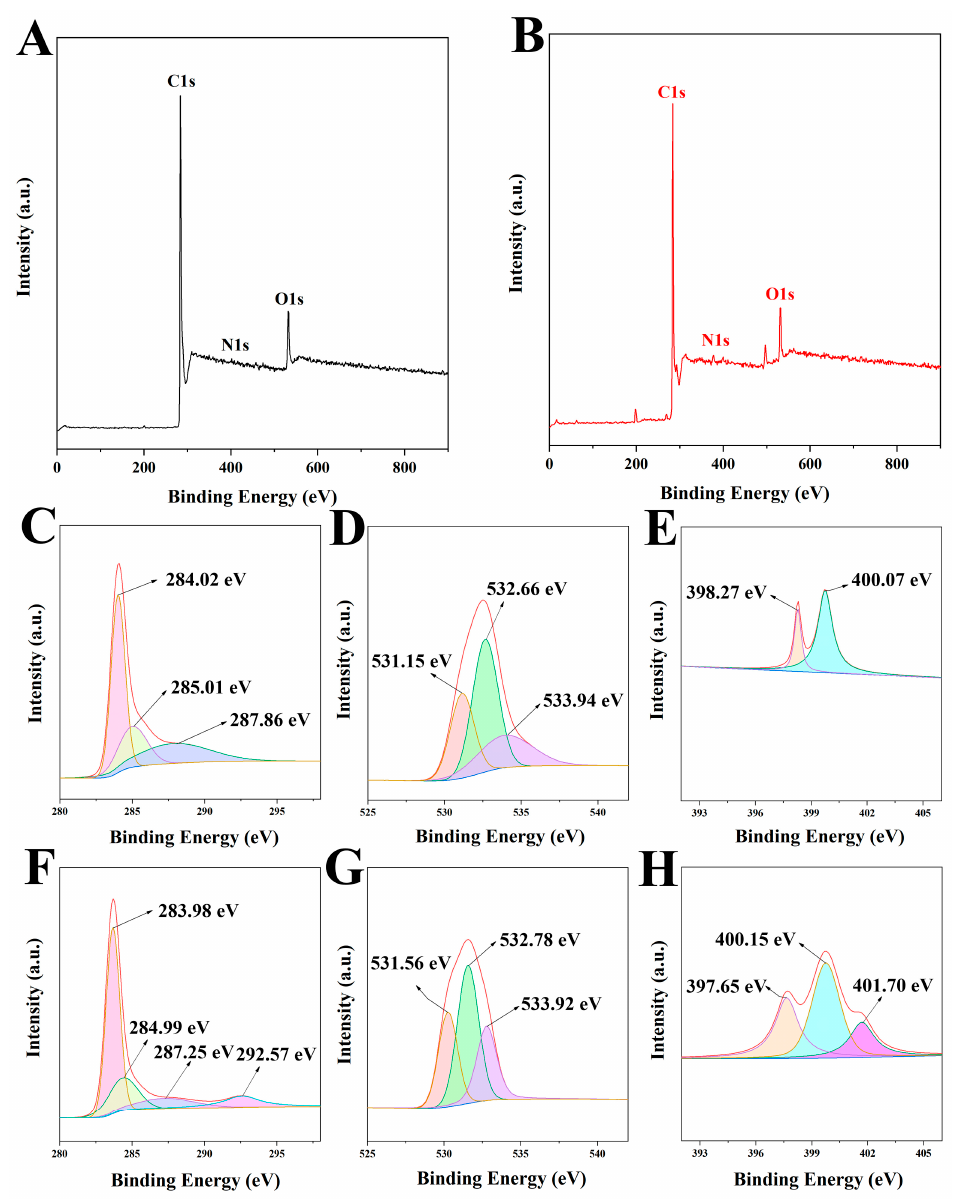
Figure 3. XPS spectra of ( A ) ITGB and ( B ) MITGB. The ( C ) C1s, ( D ) O1s, and ( E ) N1s of ITGB. The ( F ) C1s, ( G ) O1s, and ( H ) N1s of MITGB. The specific surface area and porosity of the sample were tested by N 2 adsorption- desorption isotherms as shown in Figure 4 and Table 1. The specific surface area and the total pore volume of CITG were 129.9 m 2 /g and 0.0729 cm 3 /g, meanwhile, the specific sur- face area and the total pore volume of MITG were 213.1 m 2 /g and 0.1048 cm 3 /g. It can be boldly speculated that the structure of the carbonized precursor MITG of CMITG has changed significantly after microbial treatment. Although the specific surface area of CMITG increased by nearly 83.2 m 2 /g and the total pore volume increased by about 43.76% compared with CITG, these data are not enough to support CMITG as porous bi- ochar for adsorption research. Therefore, further activation treatment is needed to greatly improve its properties and enhance its application performance. The pore-forming effect of activators commonly used in biochar preparation (such as NaOH and KOH) is beyond doubt, therefore, MB was used as an activator for biochar preparation in order to comprehensively improve pore structure (both micropore and